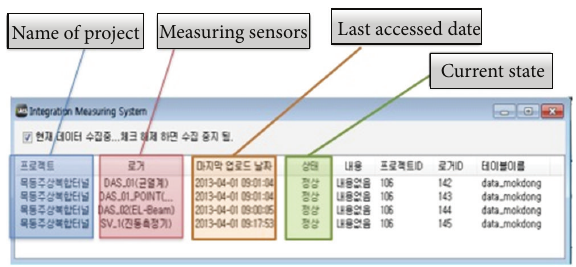
Figure 6: Integration measuring system (IMS)